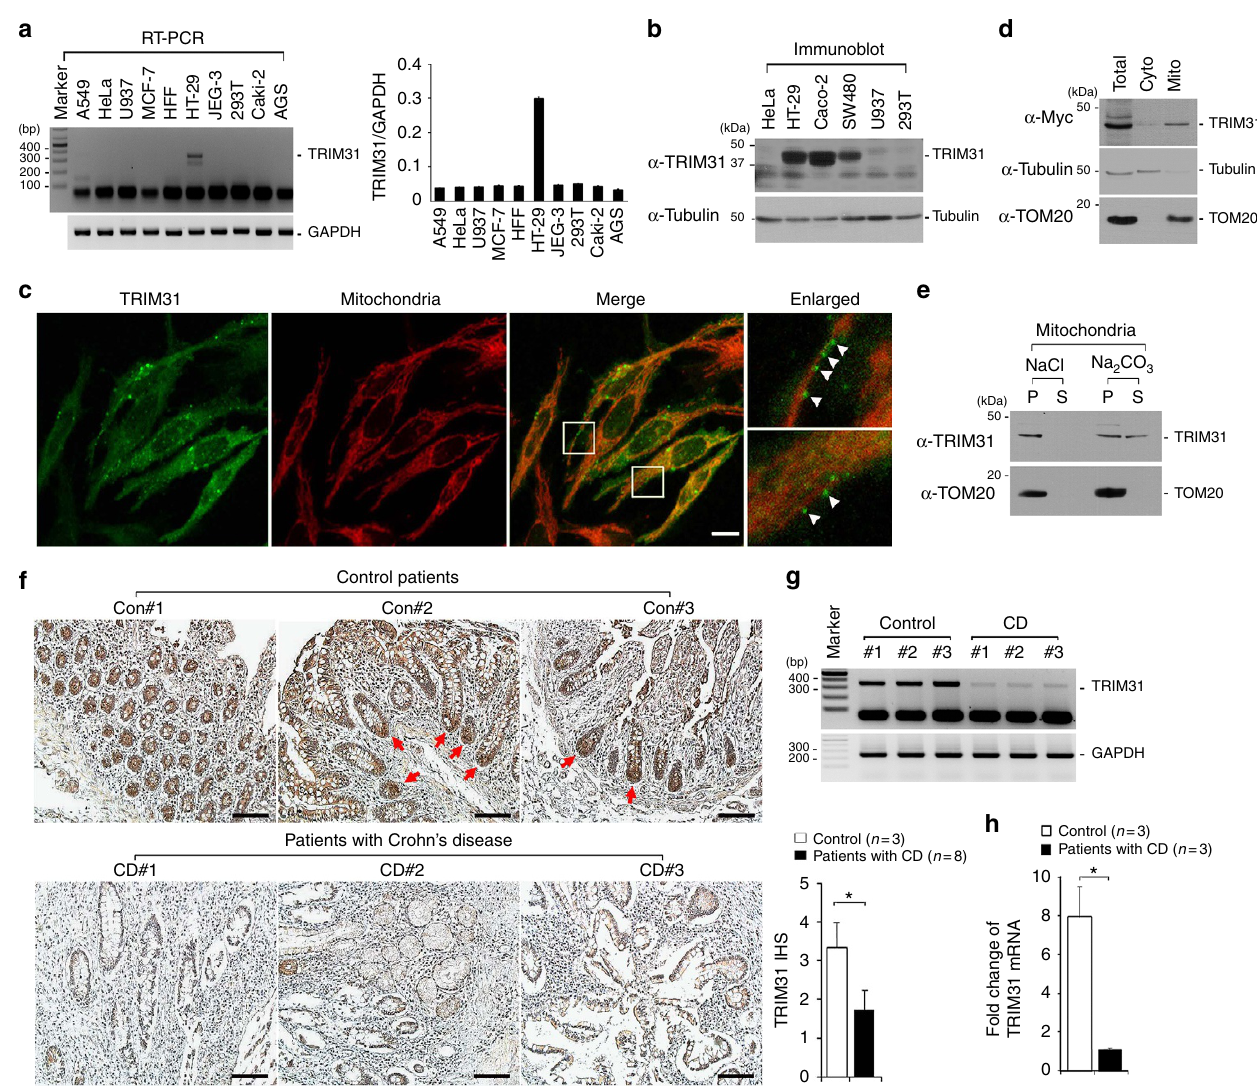
Figure 1 | Human TRIM31 is enriched in the mitochondria and downregulated in Crohn’s disease. ( a , b ) TRIM31 is highly expressed in colonic and intestinal epithelial cell lines. The expression of TRIM31 was analysed by RT-PCR ( a ) or immunoblot analysis ( b ) in various human cell lines: SW480 (colon), HT-29 (colon), and Caco-2 (intestine), A549 (lung), HeLa (cervix), U937 (lymphocyte), MCF-7 (breast), HFF (fibroblast), JEG-3 (placenta), 293T (embryonic kidney), Caki-2 (kidney) and AGS (stomach). Graph in a , quantification of TRIM31 mRNA levels normalized against GAPDH (mean ± s.d.). ( c ) TRIM31 is enriched in the mitochondria. Immunofluorescence assay (IFA) of HeLa cells transfected with TRIM31-Myc. Cells were immunostained with anti-Myc antibody (green) and anti-TOM20 antibody (red), followed by AlexaFluor 488- or AlexaFluor 568-conjugated antibodies. TOM20 serves as mitochondrial marker. Scale bar, 5 m m. ( d ) Mitochondrial localization of TRIM31-Myc. Cytosolic and mitochondrial fractions were isolated from TRIM31- Myc-expressing HeLa cells, and then subjected to immunoblot analysis using anti-Myc antibody. Anti-TOM20 and anti-Tubulin antibodies were used to designate the mitochondrial and cytoplasmic compartments, respectively. ( e ) TRIM31 is associated with the mitochondrial membrane. Isolated mitochondria from TRIM31-Myc-expressing HeLa cells were treated with 0.1M NaCl or 0.1M Na 2 CO 3 (pH 11.5) for 20min on ice. After centrifugation, the supernatant (S) and pellet (P) were analysed by immunoblotting using anti-TRIM31 and anti-TOM20 antibodies. ( f ) Representative immunohistochemical analysis of human TRIM31 on tripled Crohn’s disease (CD #1, #2, #3) and adjacent normal tissues from colon cancer (Con#1, #2, #3). The ileal mucosa biopsies of the distal small intestine from normal or Crohn’s disease patients were stained with anti-TRIM31 antibody. Scale bars, 100 m m. Right graph, Immunohistochemical score (IHS) of TRIM31 in normal ( n ¼ 3) or Crohn’s disease patients ( n ¼ 8). Detailed patient information is presented in Supplementary Table 2. IHS was equal to the quantity scores multiplied by the staining intensity scores. * P o 0.01 (Student’s t -test). ( g ) TRIM31 mRNA levels were determined by RT-PCR on tripled Crohn’s disease (CD #1, #2, #3) and adjacent normal tissues from colon cancer (Con#1, #2, #3). ( h ) TRIM31 mRNA levels were normalized against GAPDH in the graph. * P o 0.01 (Student’s t -test). All data are representative of at least three independent experiments (mean ± s.d. in f , h